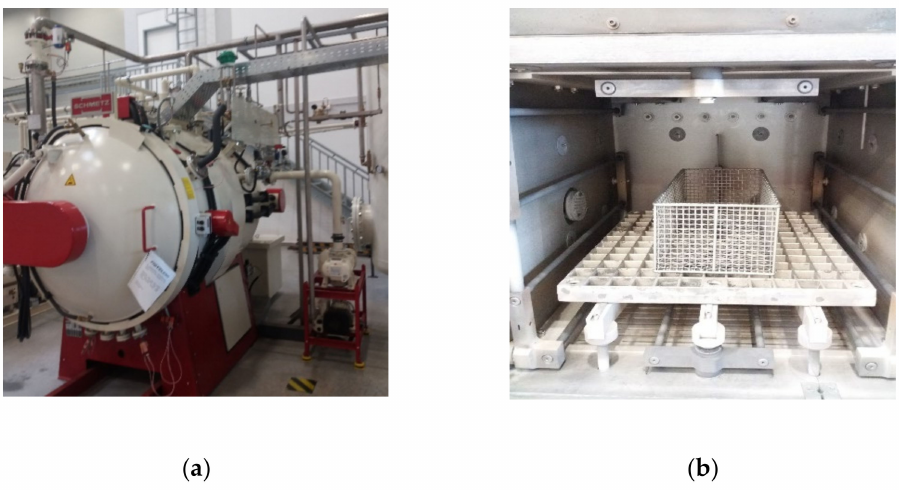
Figure 1. Schmetz vacuum furnace: ( a ) furnace setup and ( b ) furnace chamber and sample